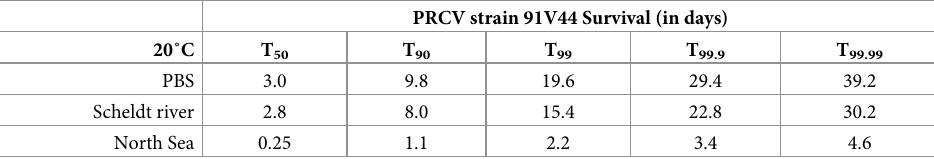
Table 4. Survival of PRCV in PBS, filtered river water and filtered